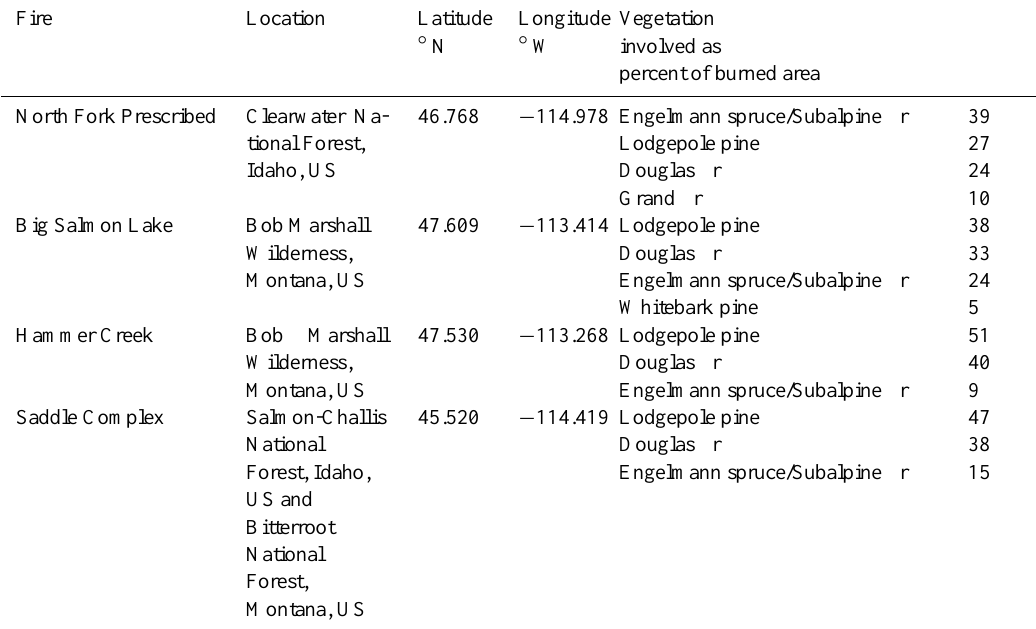
Table 1. Name, location, and vegetation involved of the fires sampled in this study. Fire Location Latitude North Fork Prescribed Clearwater Na-